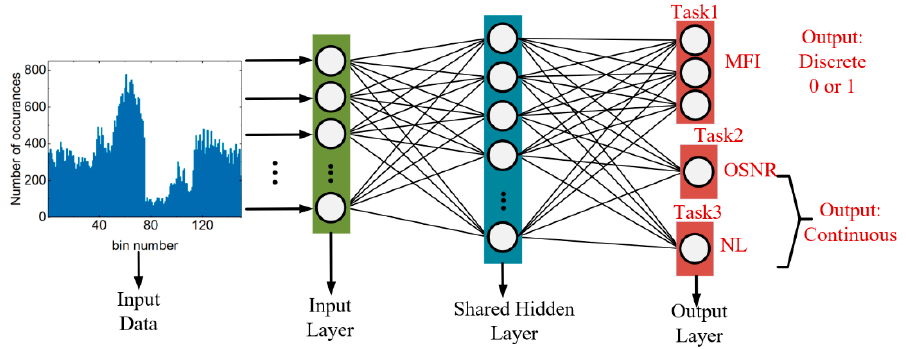
Figure 5. Schematic diagram of MT-ANN.